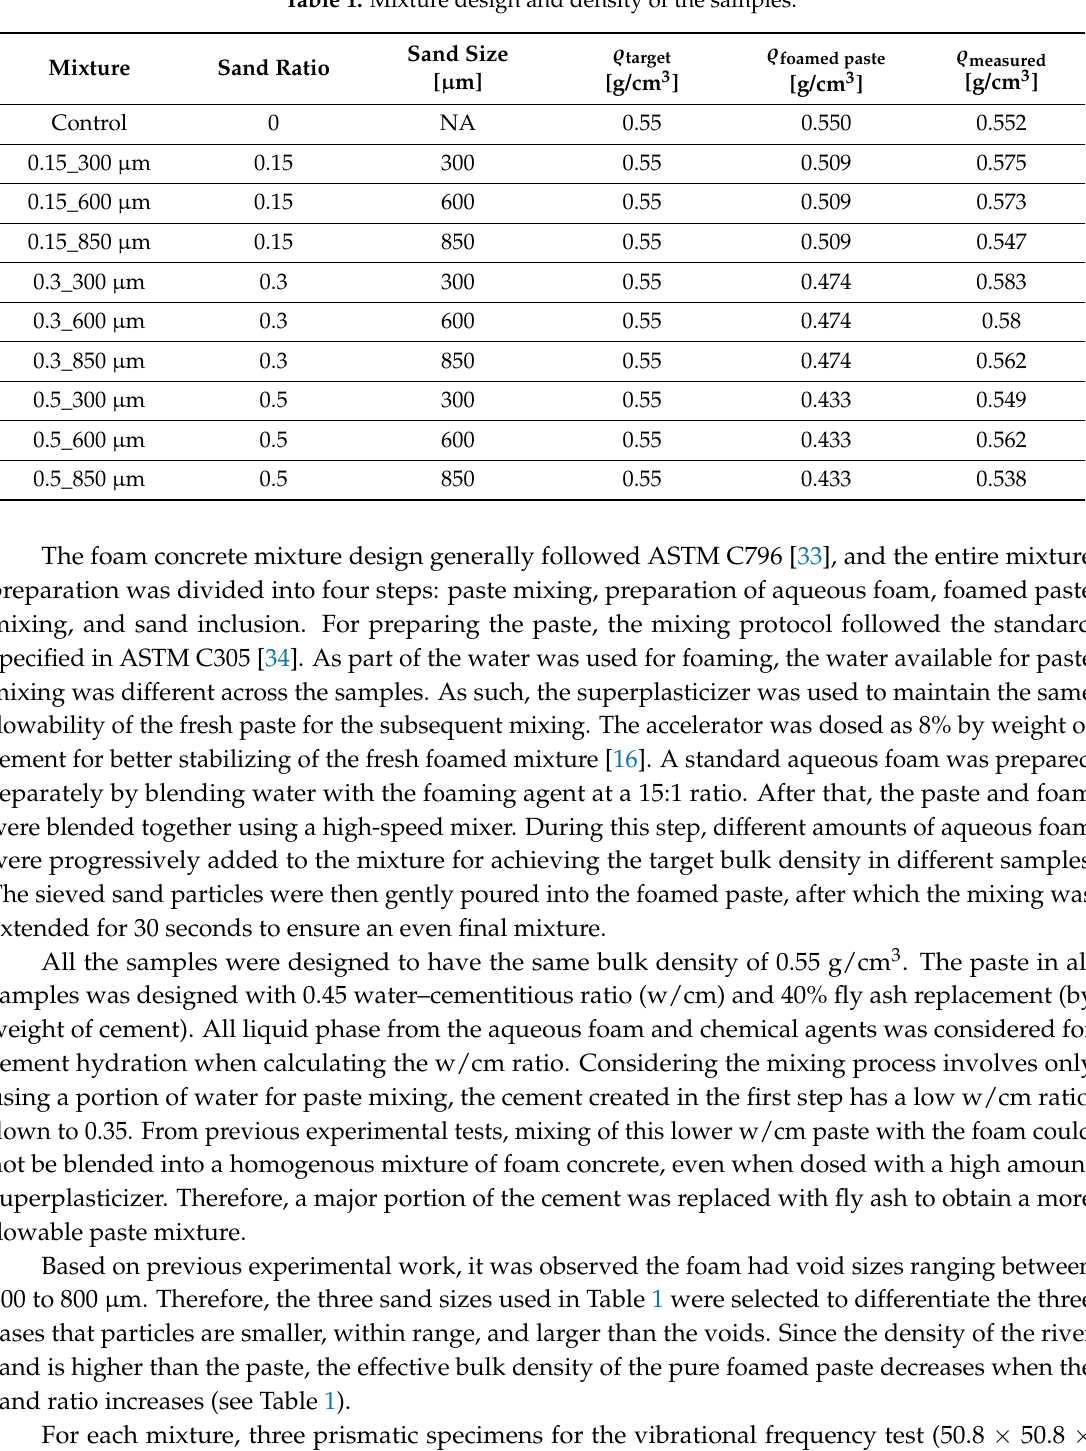
Table 1. Mixture design and density of the